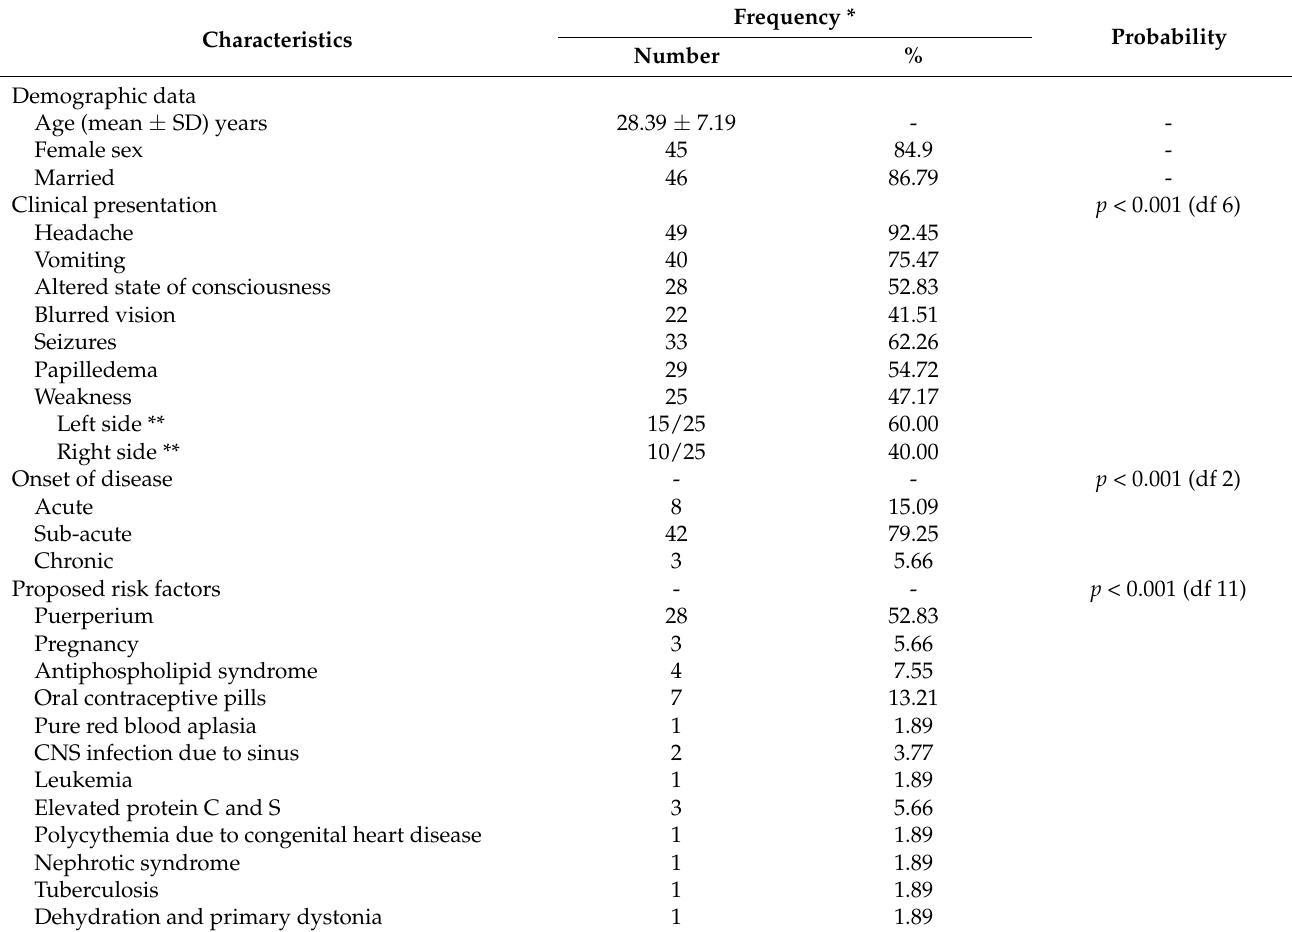
Table 1. Demographic data, clinical characteristics, and risk factors of patients ( n = 53).